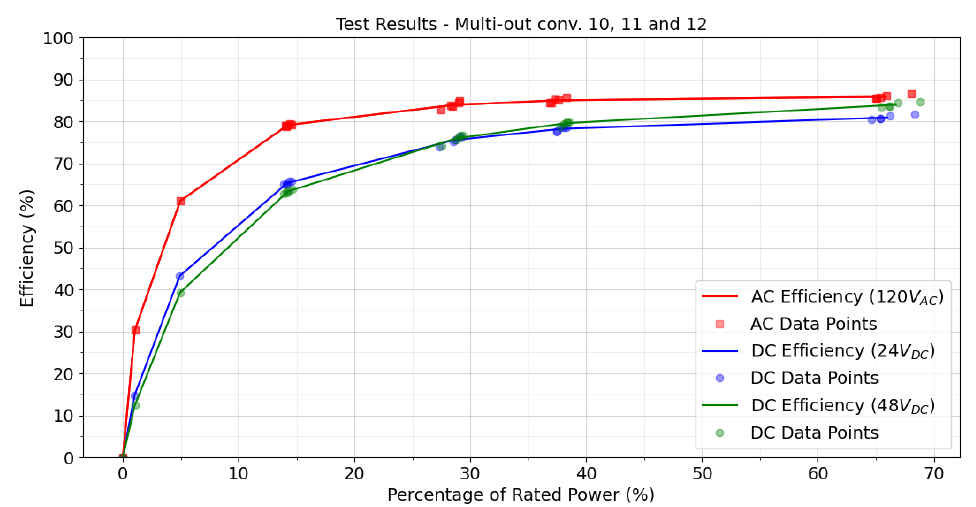
Figure 6. AC and DC efficiency comparisons for 110 W SIMO power supplies for the test plan in Table S1. The converter 10 is the AC/DC converter (red line); the blue line shows converter 11, a DC/DC converter with 24 V DC input; and the green line indicates converter 12 with a 48 V DC input.